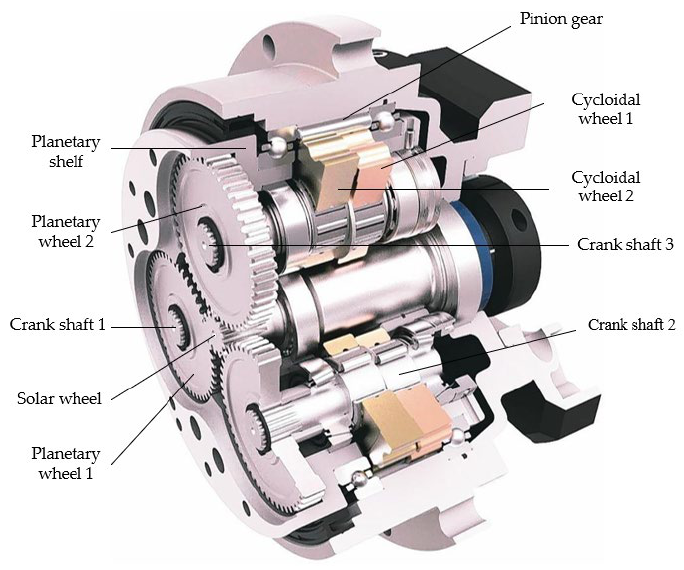
Figure 1. Structure diagram of RV reducer of industrial robot.